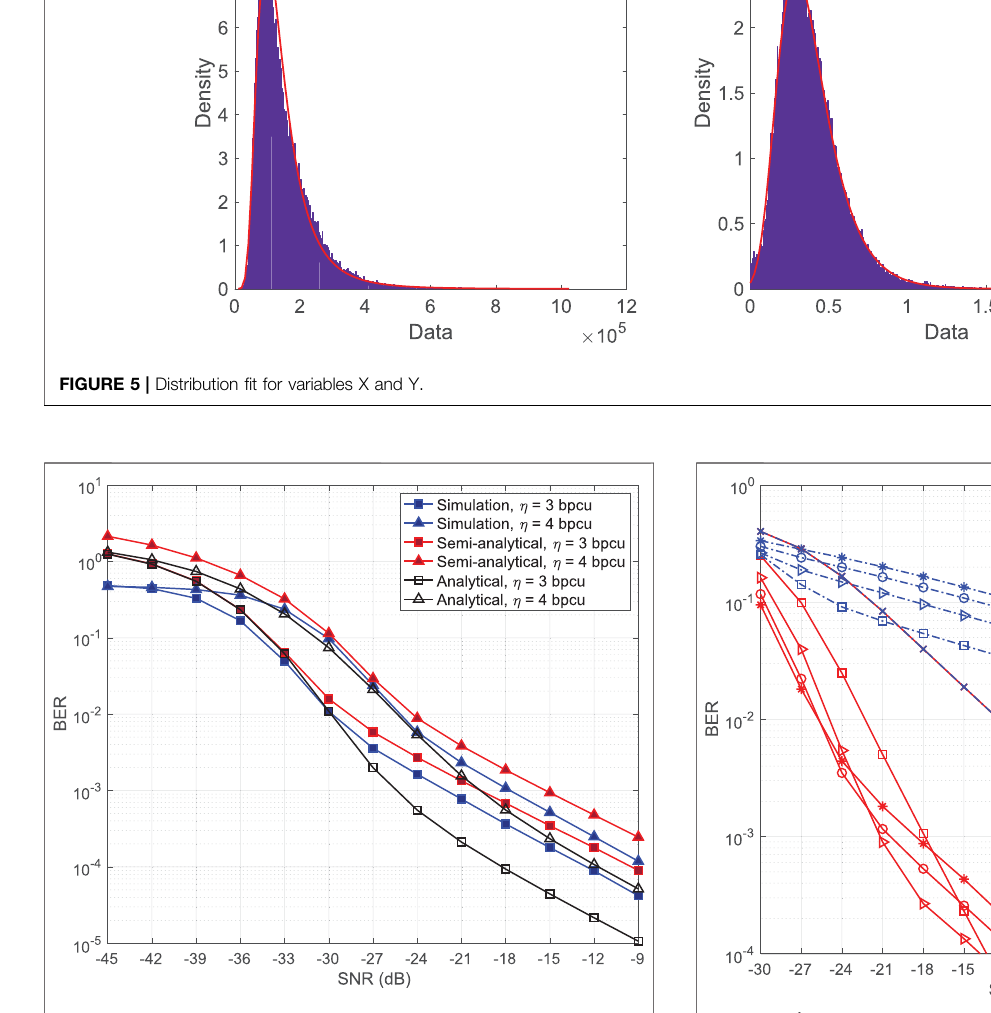
FIGURE 6 | Theoretical and simulation performance comparison for hybrid architecture.